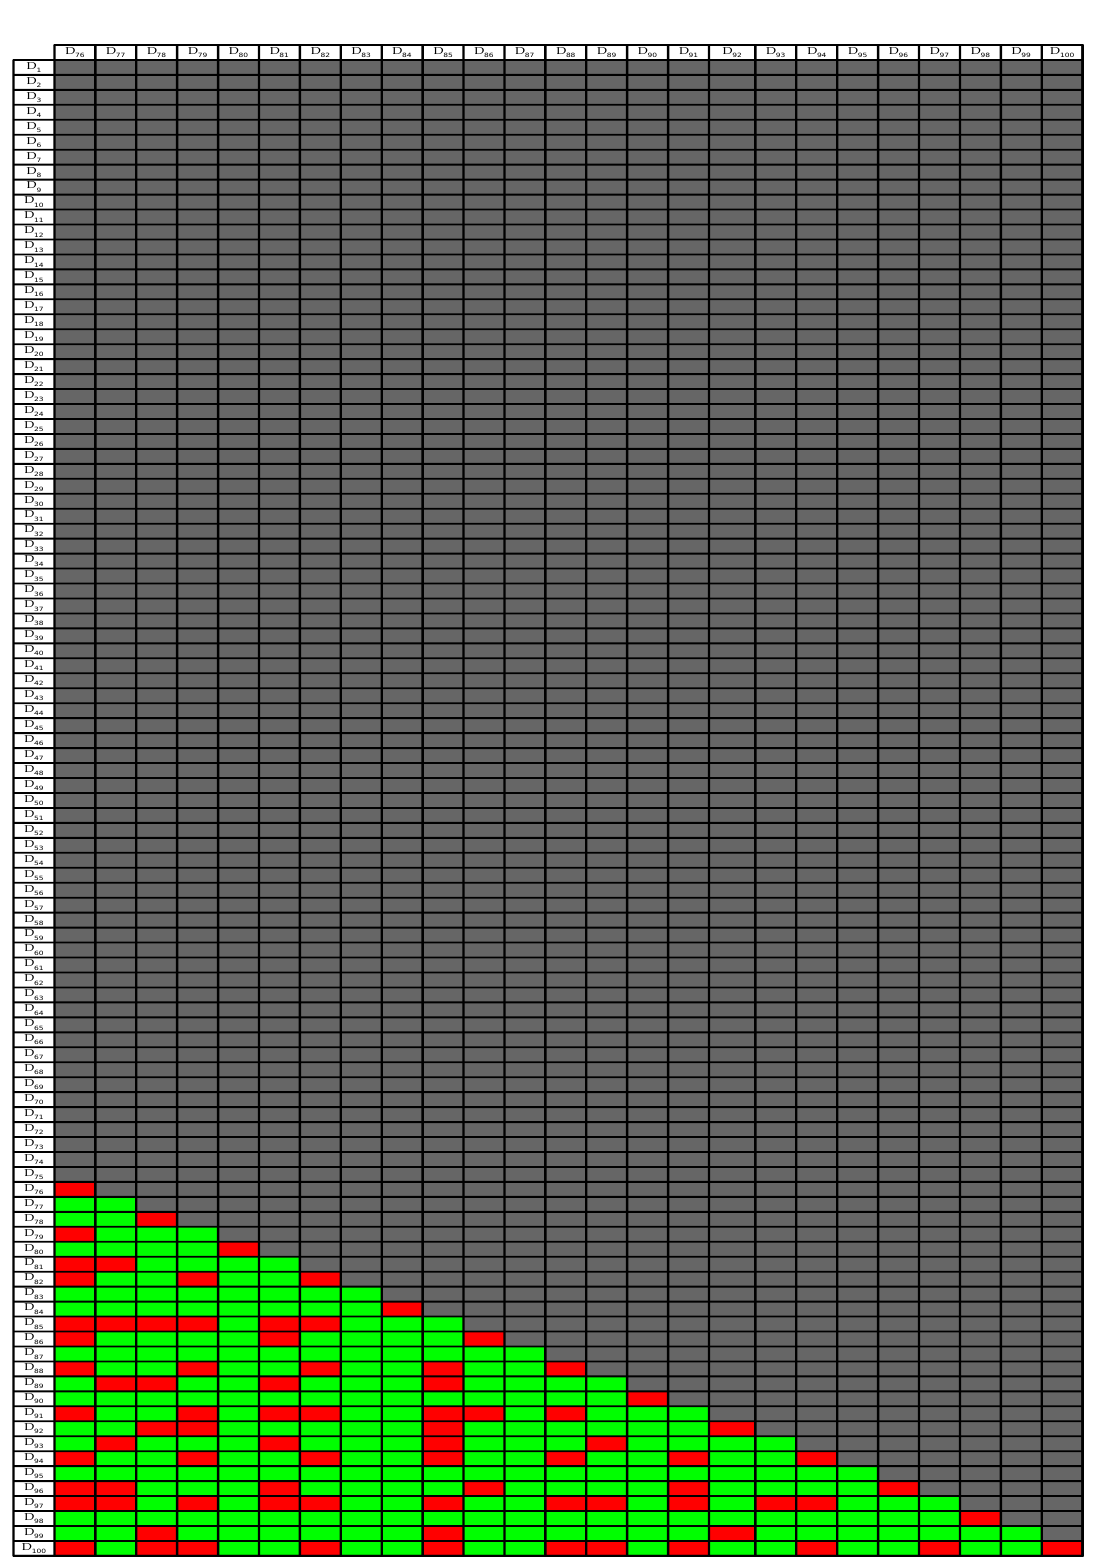
Table 13 . Analyzed theories for ( D n ; D m ) with n = 3 ; : : : 100 and m = 76 ; : : : 100.